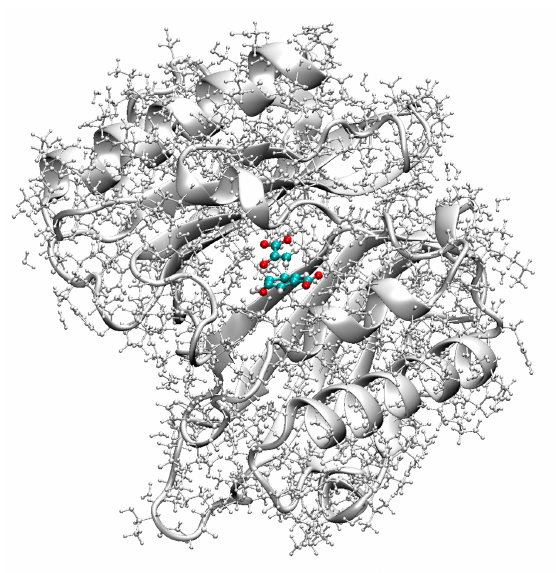
Figure 8. QM/MM optimized geometry of the BsCM-chorismate complex (ca. 5000 atoms), performed without any geometry constraints, allowing both the enzyme and substrate to relax to their optimal conformation, B3LYP/6-31+G(d,p)/AMBER level of theory.